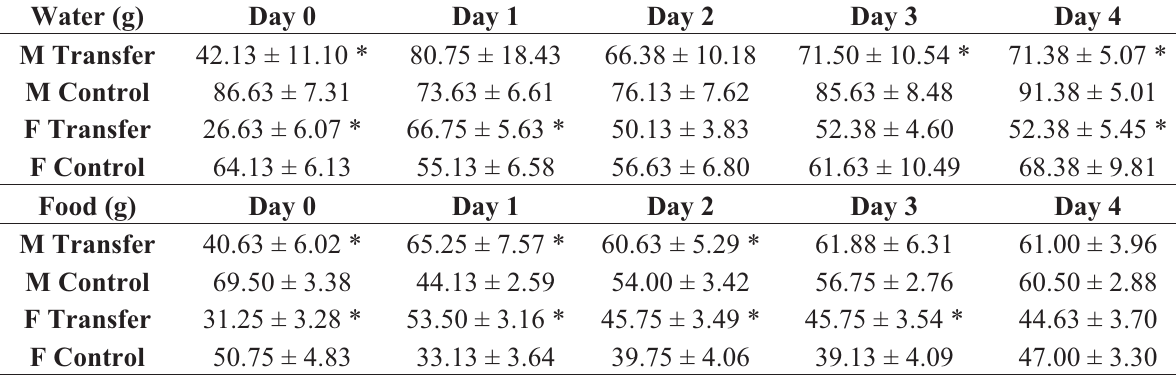
Table 1. Water and food intake (mean ± SD grams) per cage of transferred and control rats (M = male and F = female). Day 0 is day of transfer. * Significantly different from control per t -test ( p < 0.025) between transfer and control group, n = 8 cages of three animals. Water